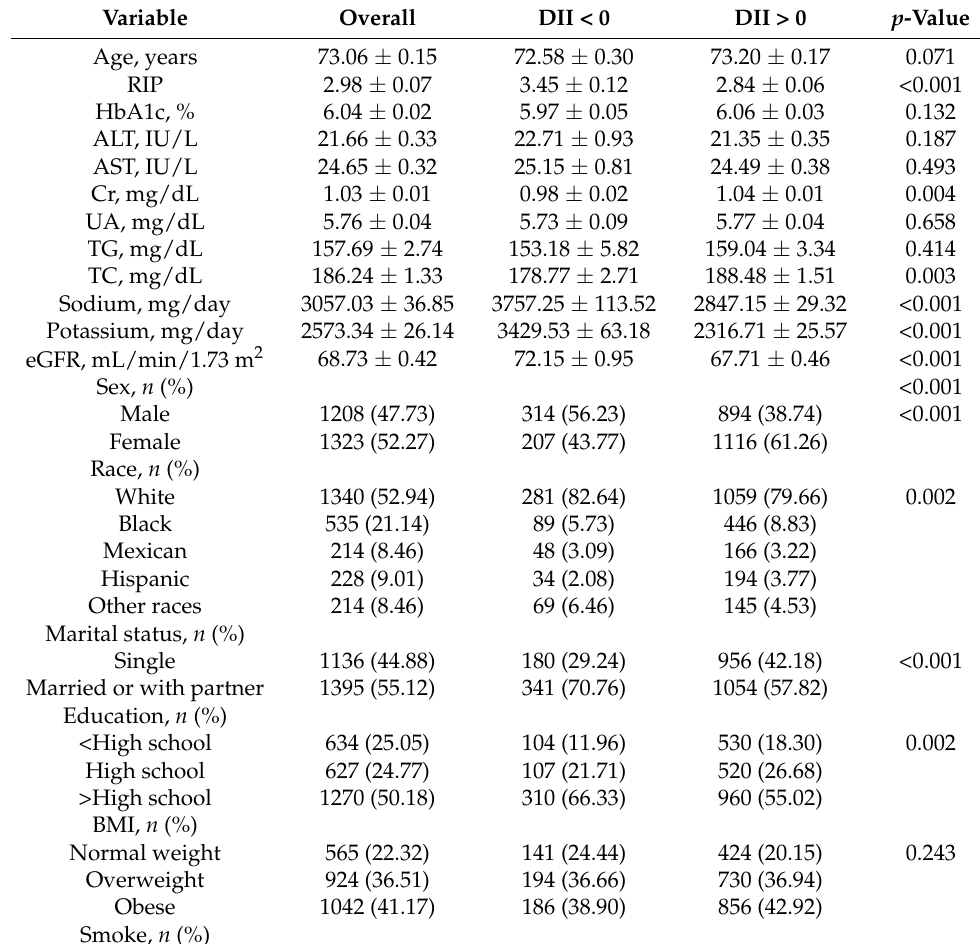
Figure 2. The Kaplan–Meier curve for the study population with different diets. Table 1. Baseline characteristics of participants.